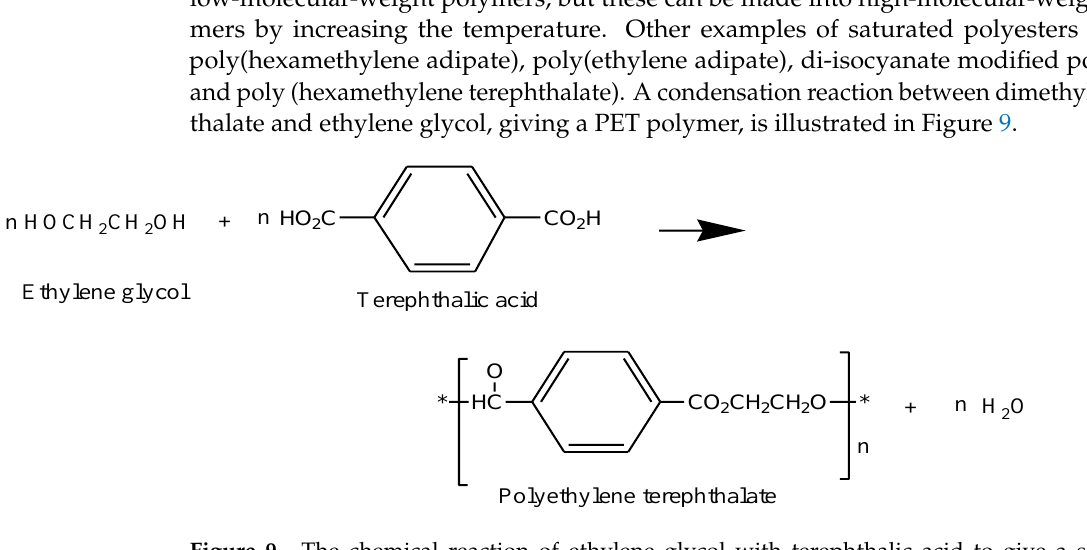
Figure 9. The chemical reaction of ethylene glycol with terephthalic acid to give a saturated polyester PET.